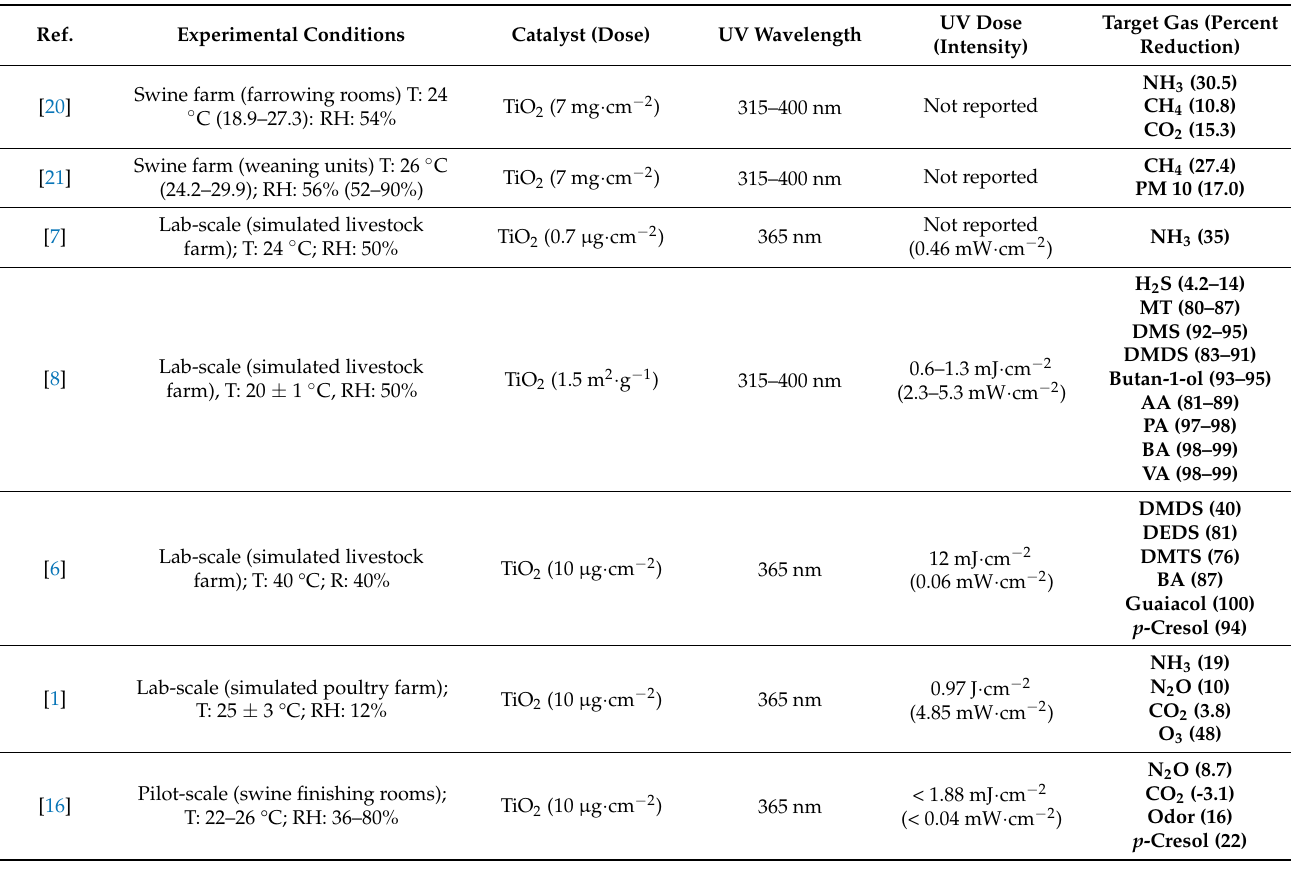
Table 15. Summary of the percent reduction of target gases investigated in the previous study with UV-A photocatalysis. Bold signifies statistical